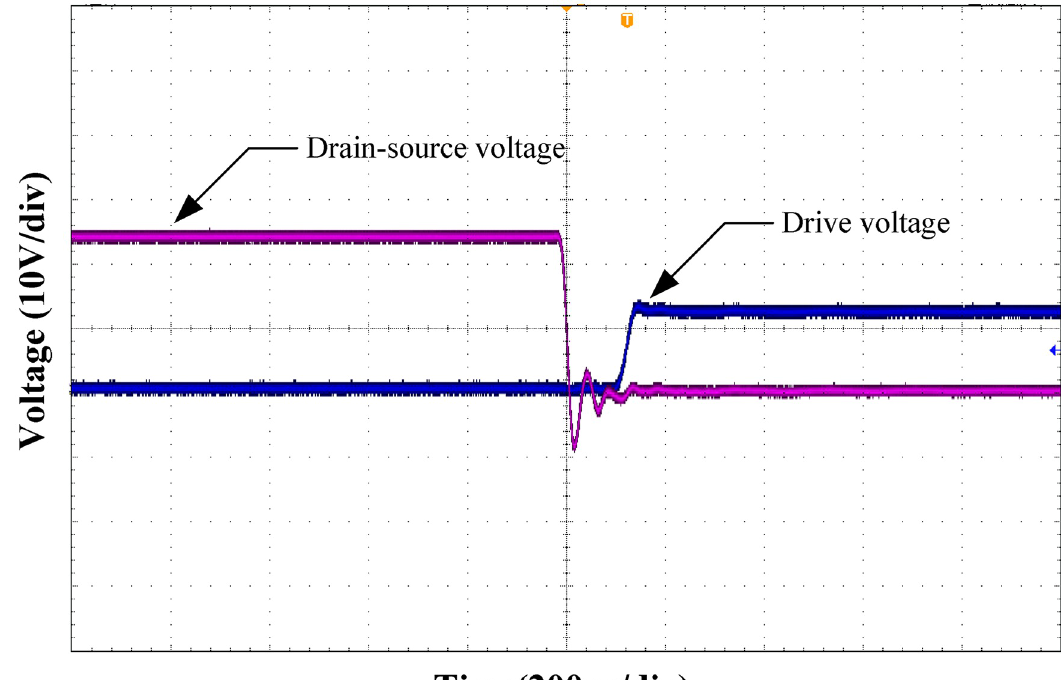
Fig 20. Zero-voltage turn-on waveform of the lagging-leg.